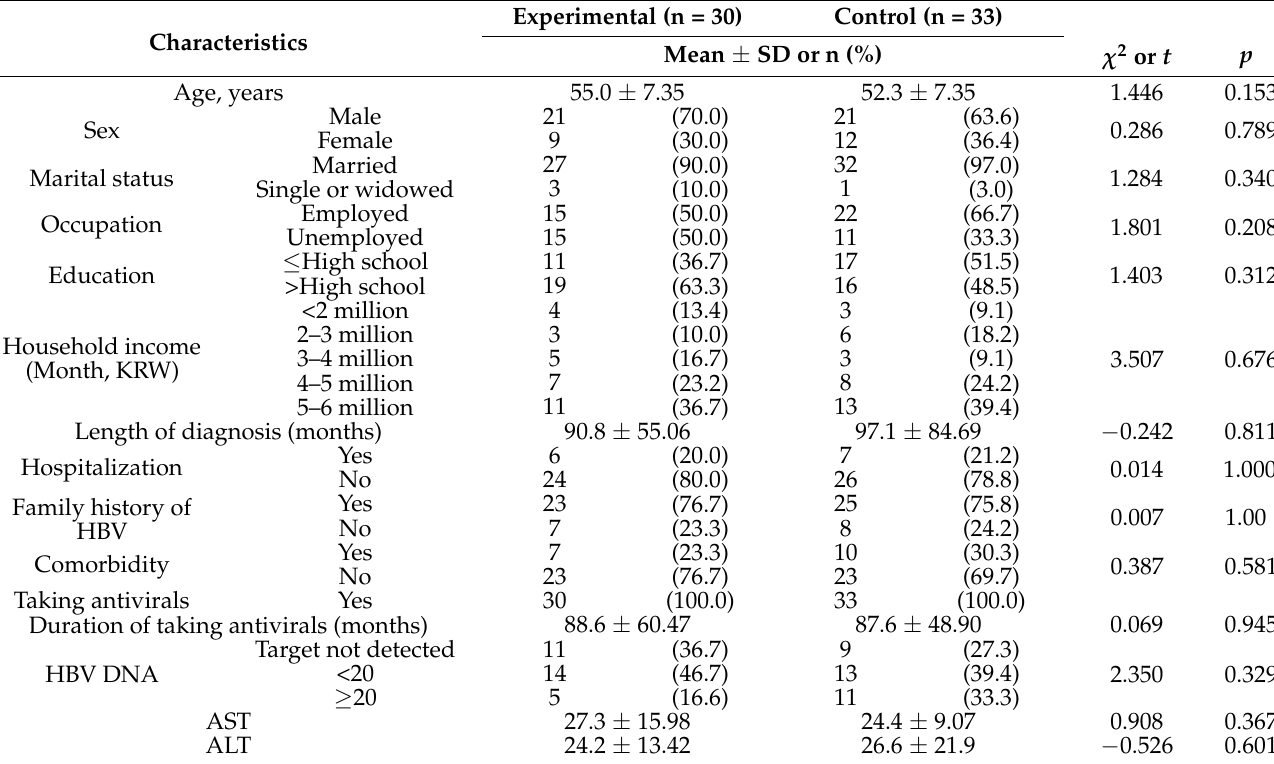
Table 1. Demographic characteristics of participants in a pilot test of a smart app for HBV management. N = 63.